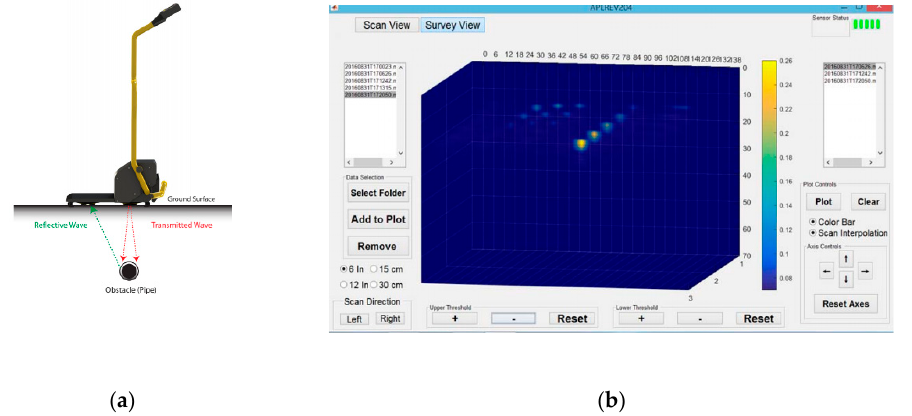
Figure 19. The Ultra-Trac ® APL ( a ) the basic principle; ( b ) the display window [118].